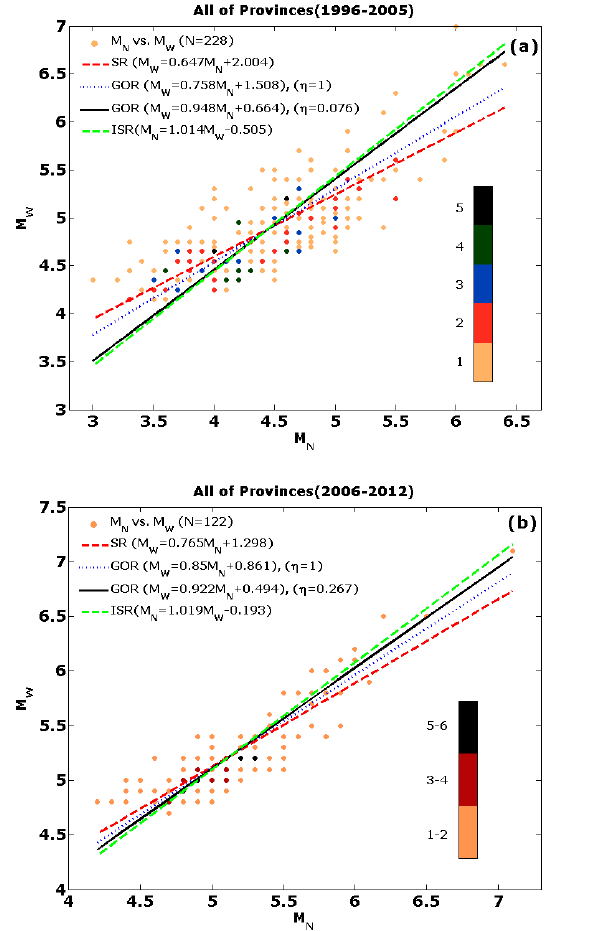
Figure 8. M –M conversion relations for two time intervals based N w on IRSC data. (a) M has been estimated according to Nuttli [1973] N has been estimated using modified Nuttli relation relation. (b) M N proposed by Rezapour et al. [2005]. Abbreviations as Figure